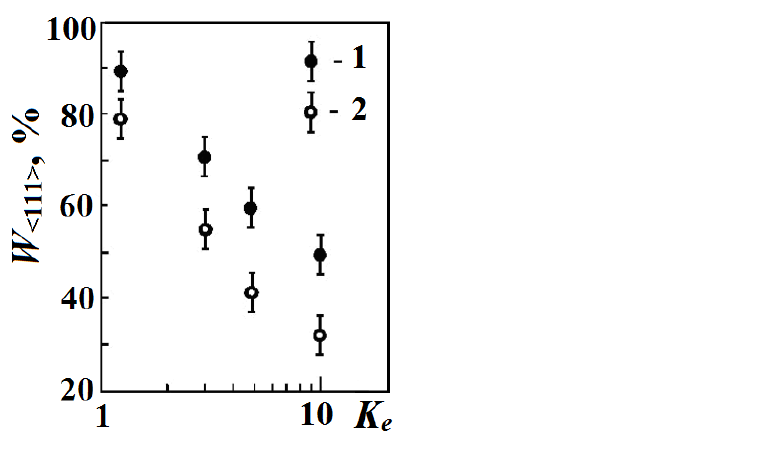
Figure 5. Influence of the extrusion ratio on the content of the crystallographic texture W <111> in as extruded Bi 0.91 Sb 0.09 crystals (1) and after annealing at 453 K for 8 h (2).